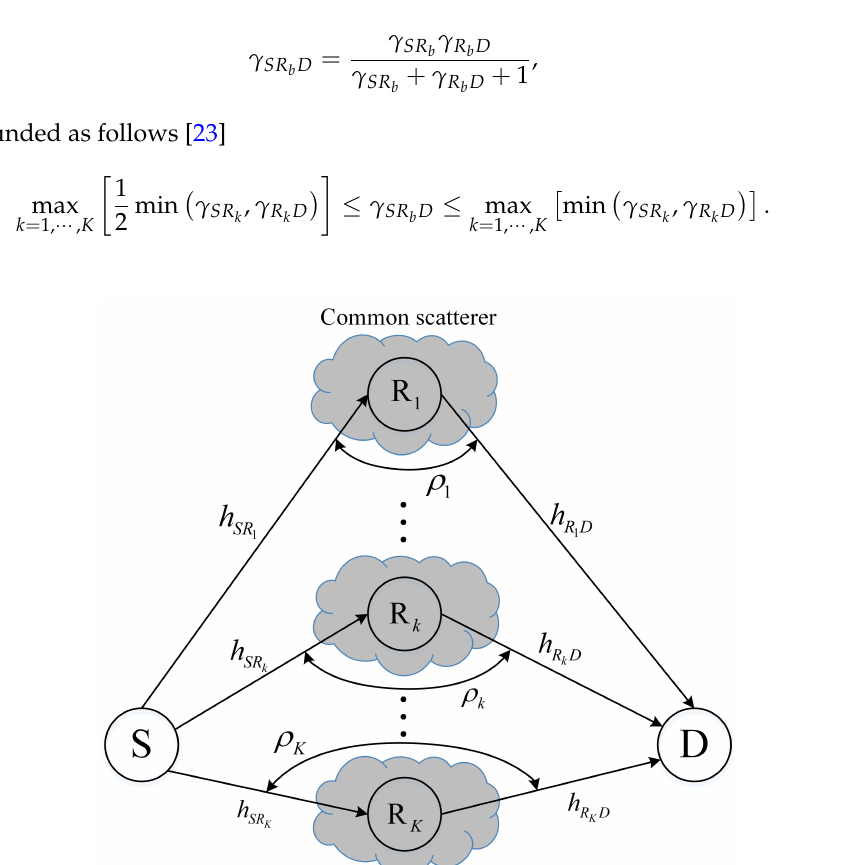
Figure 3. A multiple half-duplex AnF system in the considered correlated